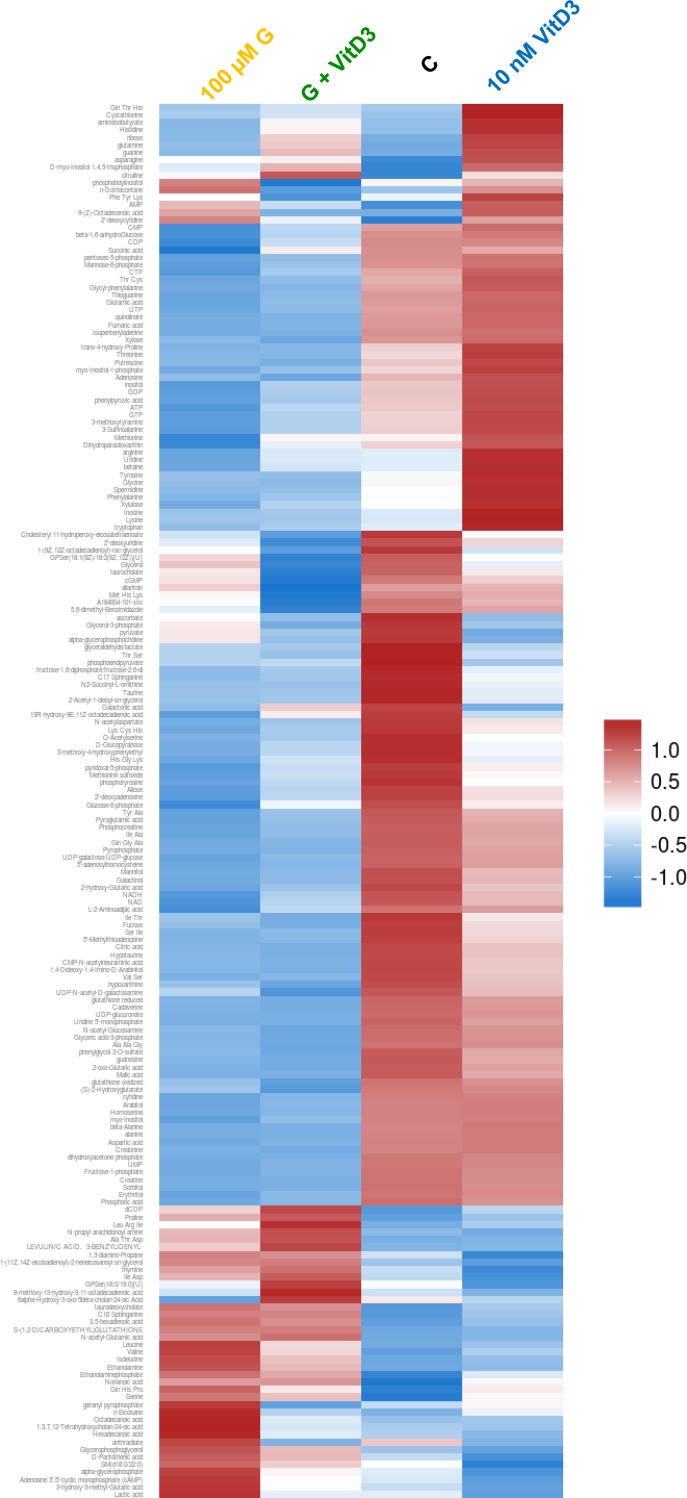
Heat map presentation of all identified metabolites by global metabolite profiling after 48 h treatment of the vehicle control, 100 μM genistein (G), 10 nM calcitriol (VitD3) and the combination of both in MG-63 cells (see color bar for scale; blue color indicates down regulated metabolites; red color indicates up regulated metabolites).